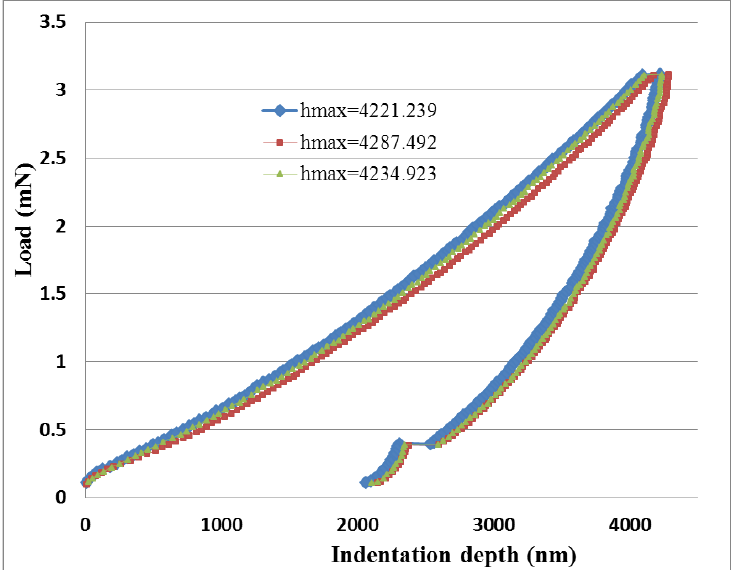
Figure 10. Load vs. indentation depth for the buckypaper made of low aspect ratio MWCNTs.